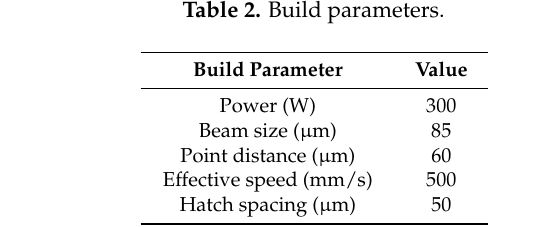
Table 1. Chemical compositions for Ti-6Al-4V used in the study (wt %). Table 2. Build parameters.